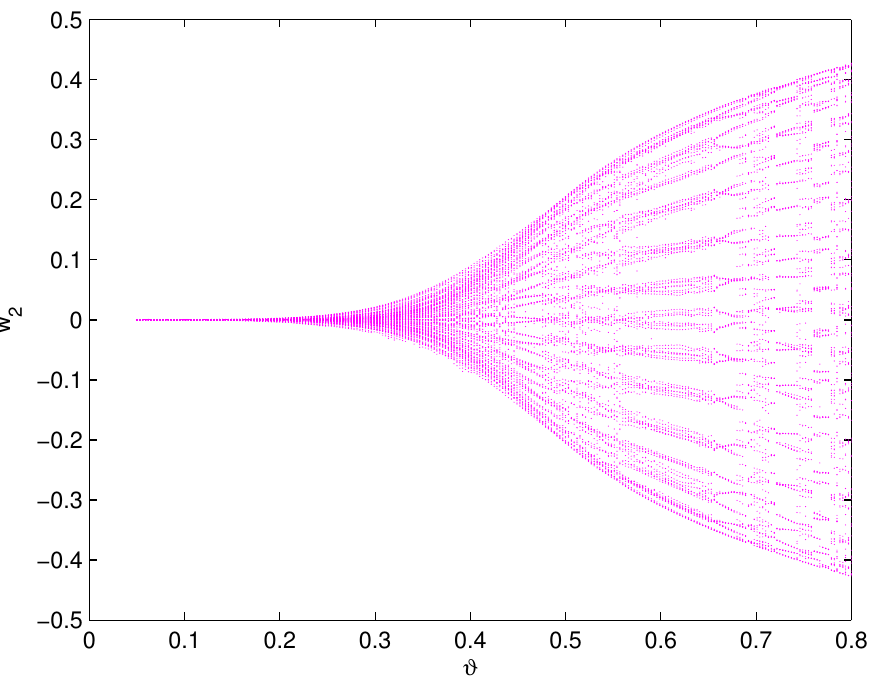
Figure 11. Bifurcation graph of system (72): the time delay ϑ versus the variable w 2 . The bifurcation number is 0.44.